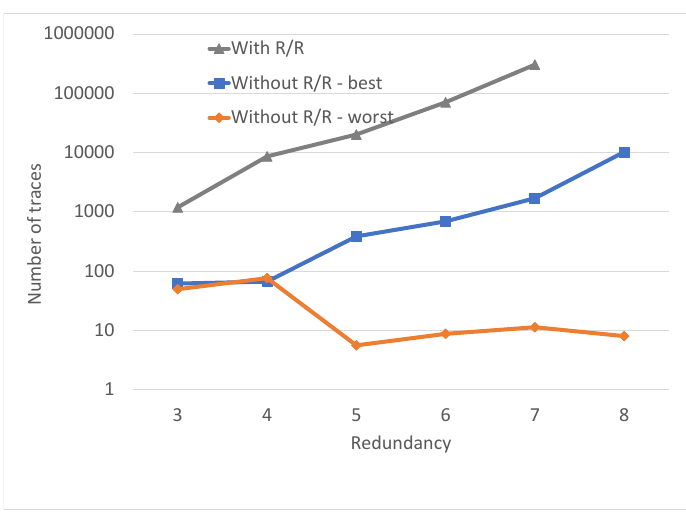
Figure 2: Number of traces at which the t-test reaches 4.5 by absolute value (without re-randomization — worst and best, and with re-randomization) which the initial randomization and the final de-randomization of the state are omitted. Thus, all the data involved in the calculations were kept in the redundant representation.